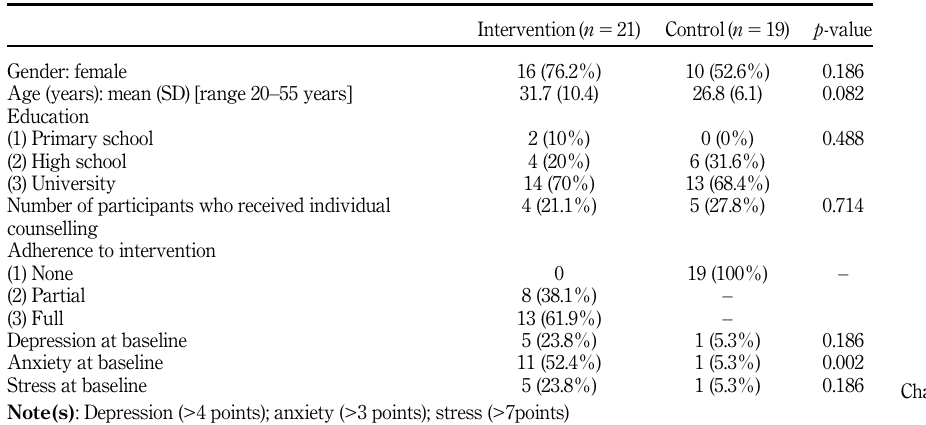
Figure 1. The enrolment and